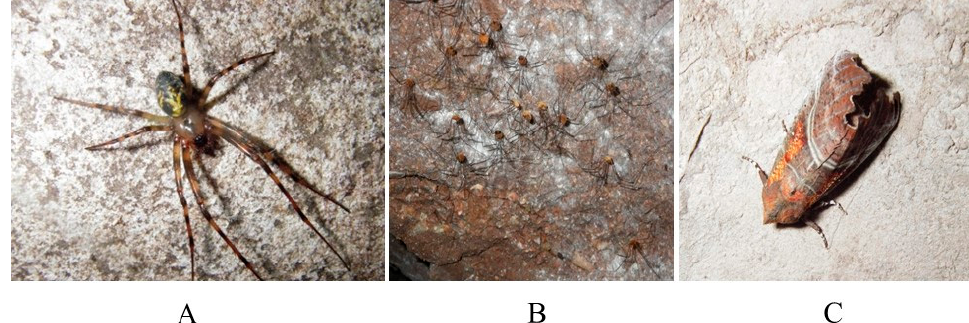
Figure 1. Principal arthropod species in New Brunswick bat hibernacula from which fungi were cultured. ( A ) Meta ovalis ; ( B ) Nelima elegans in loose aggregation; ( C ) Scoliopteryx libatrix.